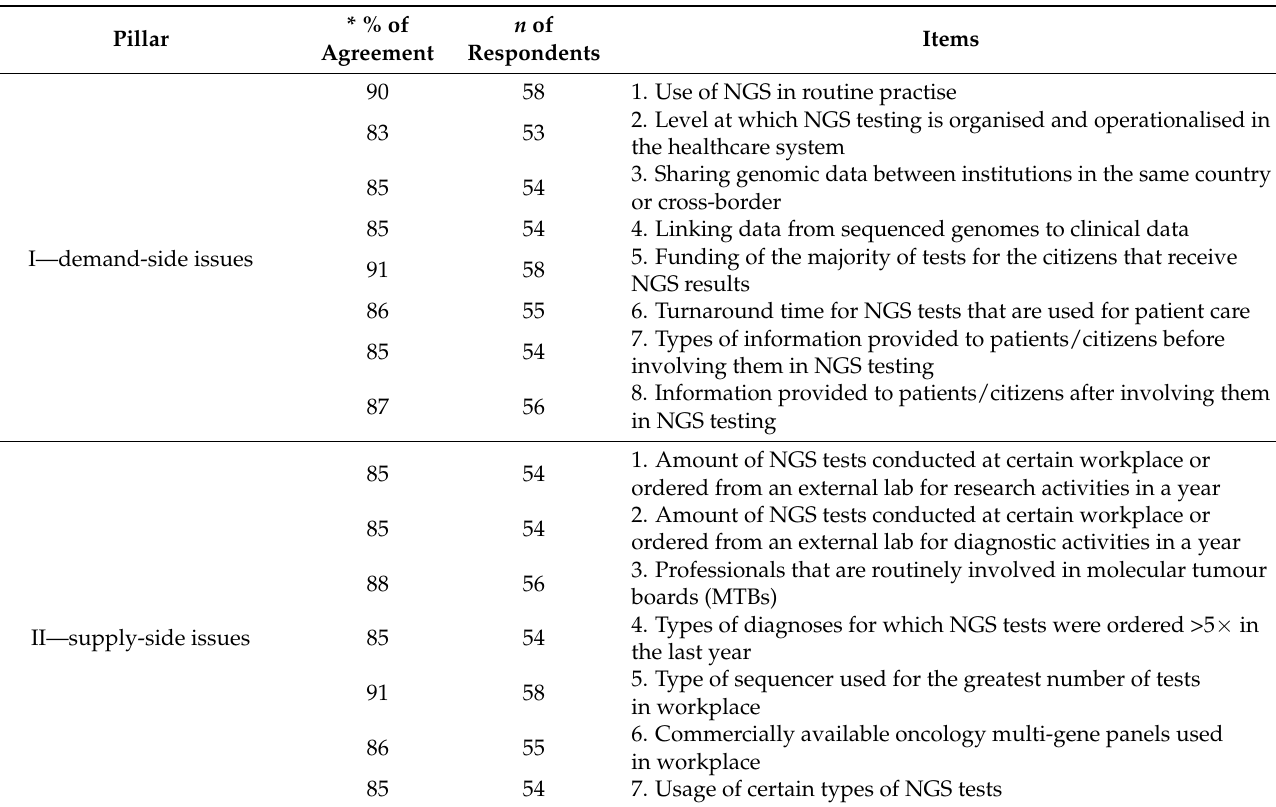
Table 1. Two main pillars, demand-side issues (Pillar I) and supply-side issues (Pillar II) with a total of 15 items validated and accepted after the second expert